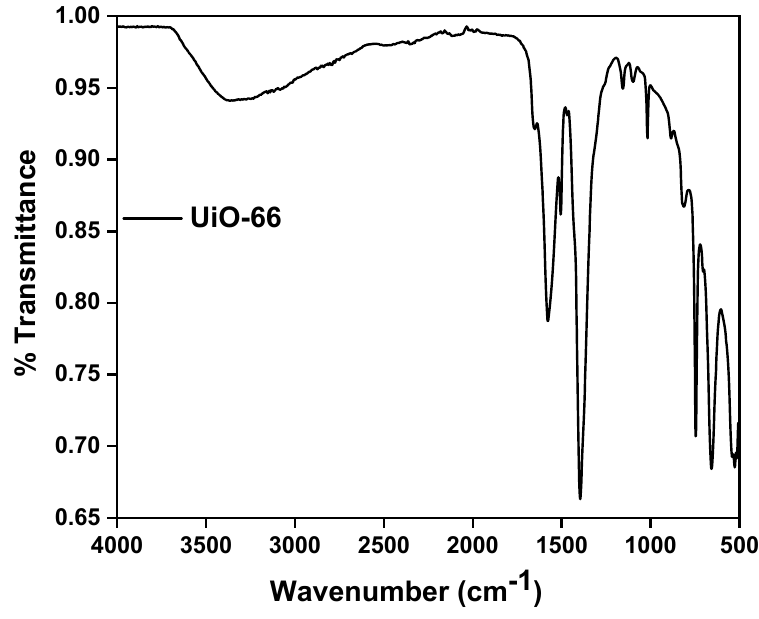
Figure 3. FT ‐ IR spectra of UiO ‐ 66.